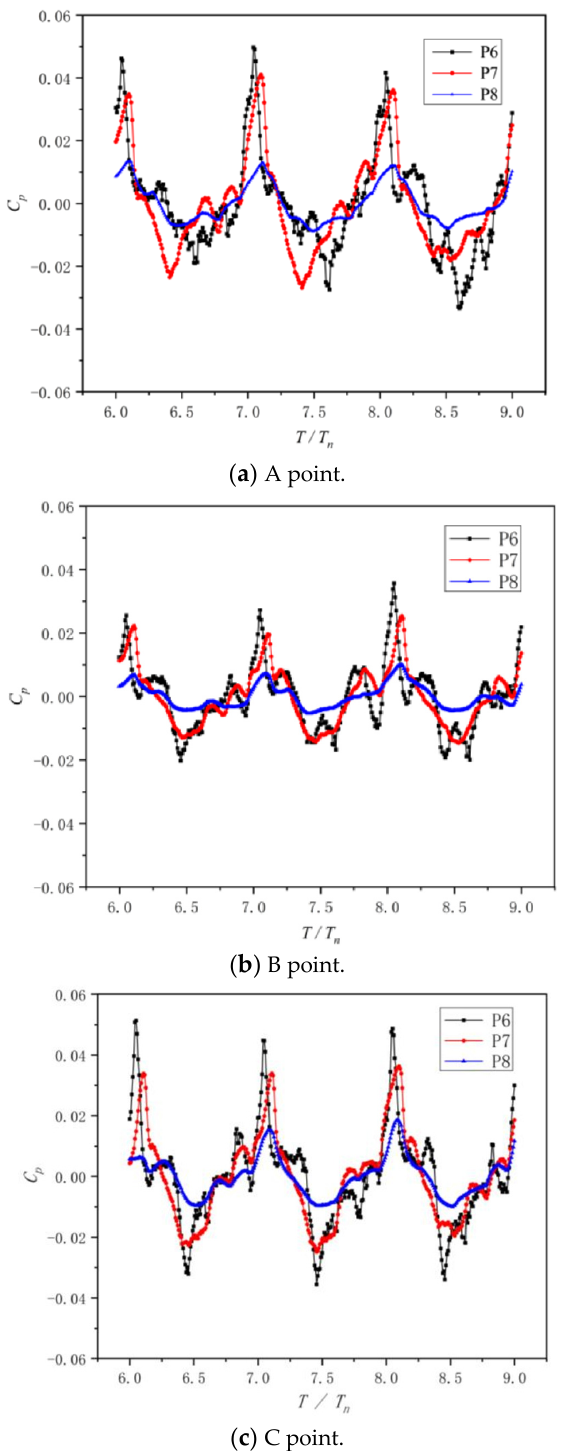
Figure 16. Pressure time domain in the rotor.